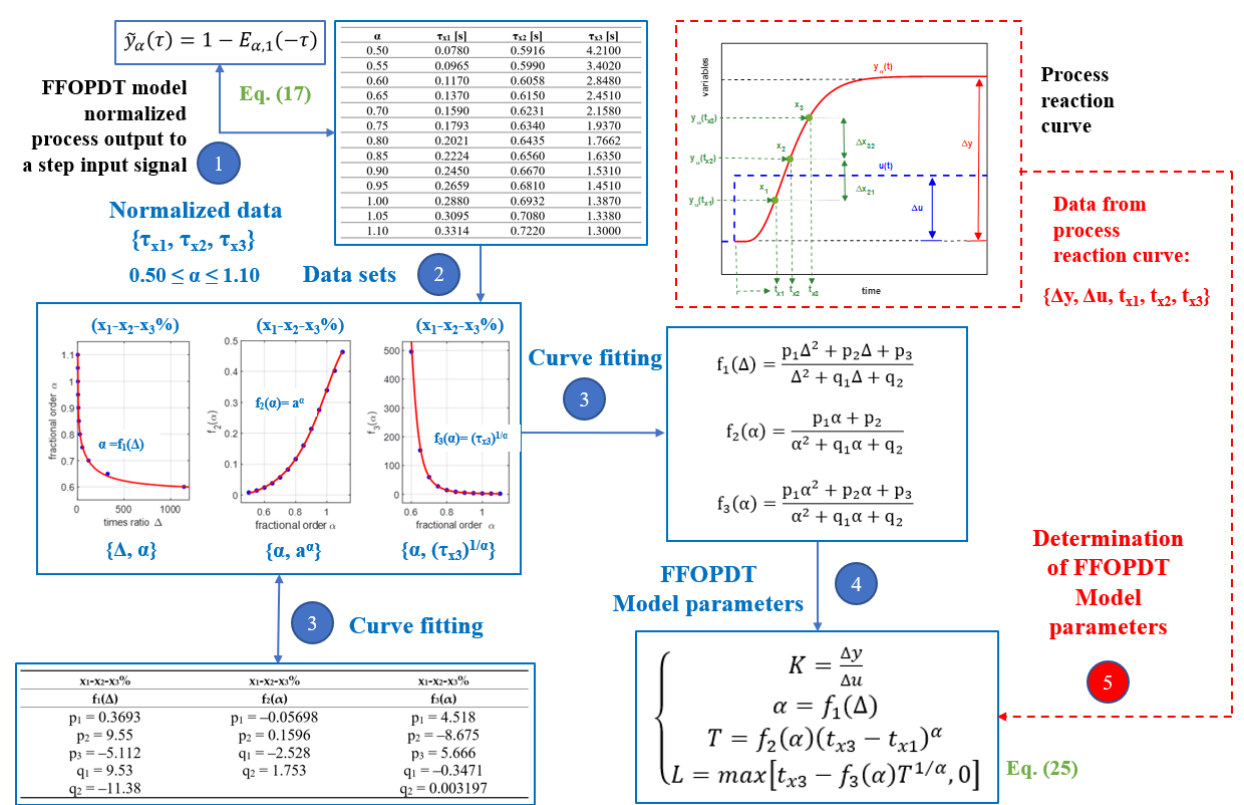
Figure 4. Scheme of the complete procedure for identifying the parameters of the fractional-order model considering three arbitrary points on the process reaction curve. Note that the blue part of the scheme (steps 1 – 4) represents the general procedure to obtain expressions (25) that allow to determine the parameters of the FFOPDT model for any three points (x 1 , x 2 , and x 3 ) on the process reaction curve. On the other hand, the red part of the scheme (step 5) indicates how to estimate the parameters θ P = {K, T, L, α} from the information collected from the process reaction curve {Δy, Δu, t x1 , t x2 , t x3 }. A detailed algorithm for estimating the FFOPDT model parameters, θ P = {K, T, L, α }, from the information collected from the process reaction curve is provided in Section